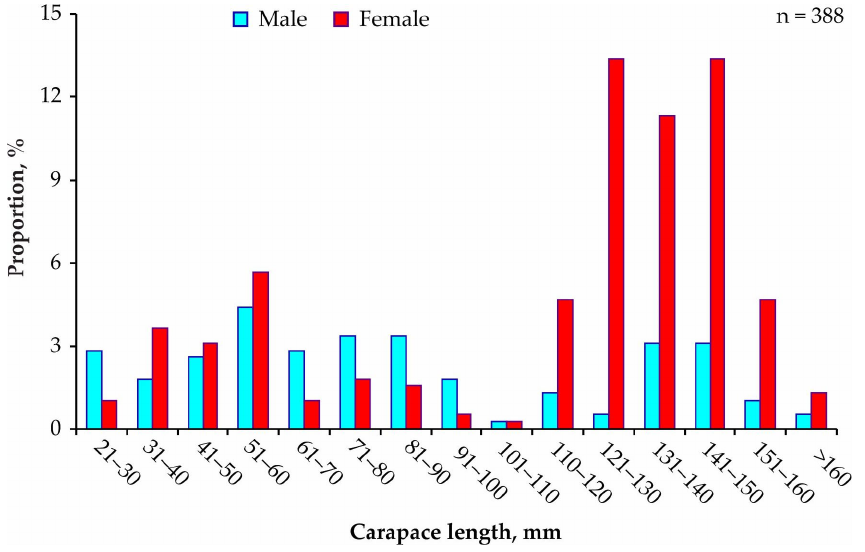
Figure 2. Size–frequency distribution of red king crabs analyzed for associated taxa in 2009–2013. Among adult crabs (CL > 90 mm), the sex ratio was different from the 1:1 expected ratio, with females outnumbering males (F:M = 4.3:1, χ 2 = 91.18, df = 1, p < 0.001). Mature crabs were mainly represented by individuals belonging to the 121–130, 131–140, and 141–150 mm size classes (Figure 2). Mean CL and weight were higher in females (113.9 ± 2.4 mm and 1311 ± 49 g) than in males (84.0 ± 3.6 mm and 812 ± 90 g), which was confirmed by statistical analysis (ANOVA, df = 1, p < 0.001 in both cases). The majority of red king crabs had new shells (age of exoskeleton <1 year prior to sampling): 97.4% among small crabs, 97.4% among large females, and 48.9% among large males. New-shelled crabs had no brown scratching on the coxa or ventral surface of the exoskeleton, spines and dactyls showed only slight wear, and the gills were light cream in color. Premolt and soft-shell (recently molted) crabs were most frequent among